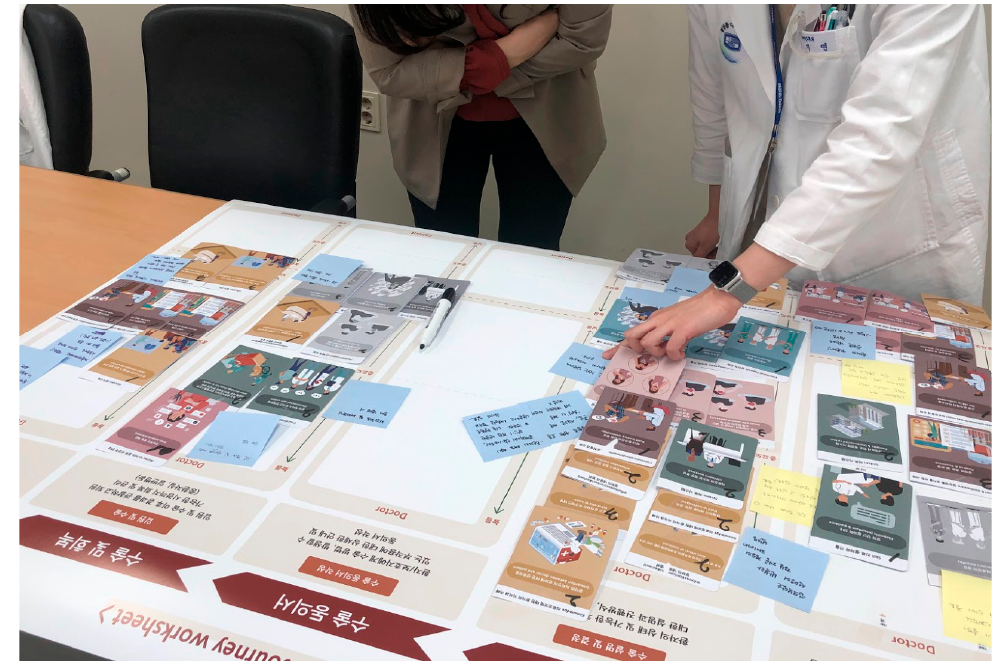
Figure 4. PE factors allo tt ed on the HNC patient journey map showing the importance